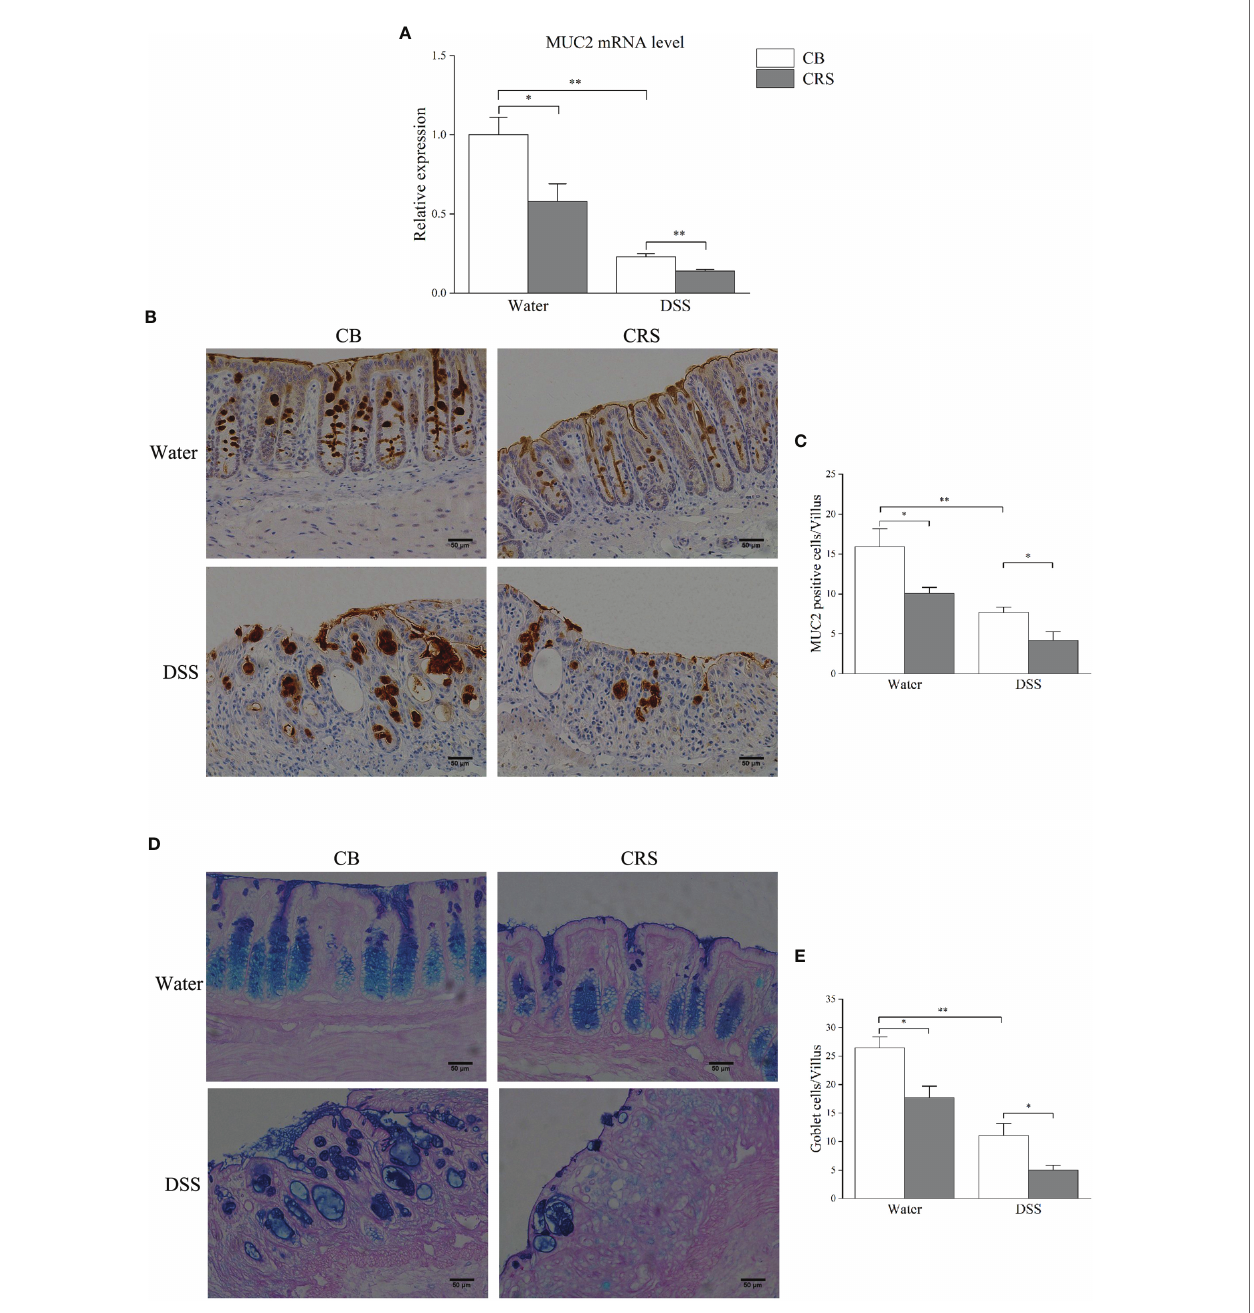
FIGURE 6 | Chronic restraint stress prompted colonic mucosal barrier damage. (A) Relative expression of MUC2 was validated by qPCR. (B) Representative pictures shown immunostaining of MUC2 in colon (magni fi cation ×200, scale bar: 50 m m). (C) The numbers of MUC2-positive cells in each villus (n = 4 – 5); (D) Representative pictures showing that colonic specimens stained with PAS/AB (magni fi cation ×200, scale bar: 50 m m); (E) Numbers of goblet cells in each villus (n = 4 – 5). *p < 0.05, **p <